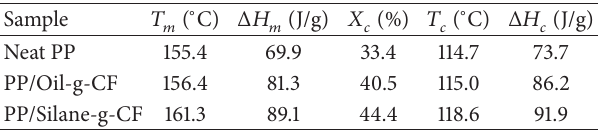
Table 1: Thermal properties of neat PP and PP/Oil-g-CF composite and PP/Silane-g-CF composite at the second heating and cooling